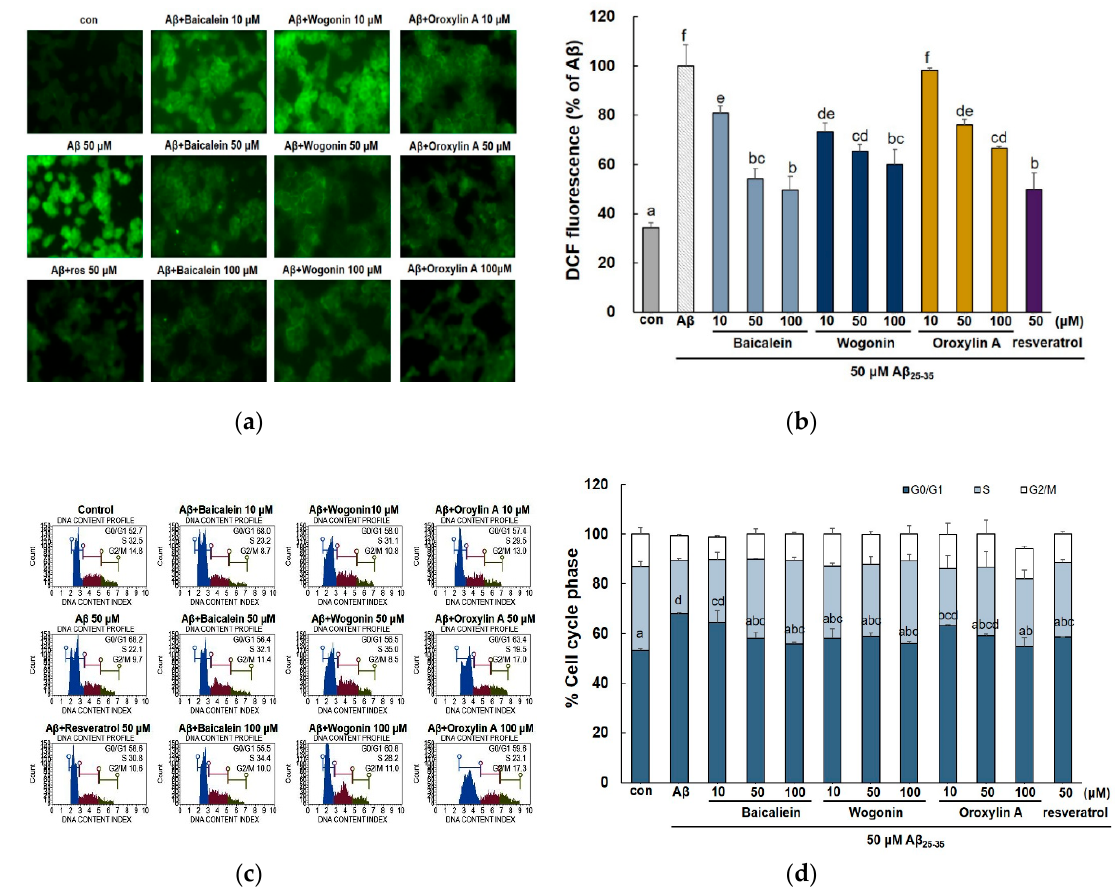
Figure 3. Effects of baicalein, wogonin and oroxylin A on intracellular ROS levels and cell cycle arrest in A β 25–35 -induced PC12 cells. The cells were pretreated with samples for 1 h, and stimulated with A β 25–35 for 24 h. ROS levels were observed using CM-H 2 DCFDA ( a ) and measured by microplate reader ( b ). Cell cycle was measured by flow cytometry ( c ). Statistical analysis results of the percentage of cell cycle by flow cytometry ( d ). Different alphabets indicated significant difference at p < 0.05.